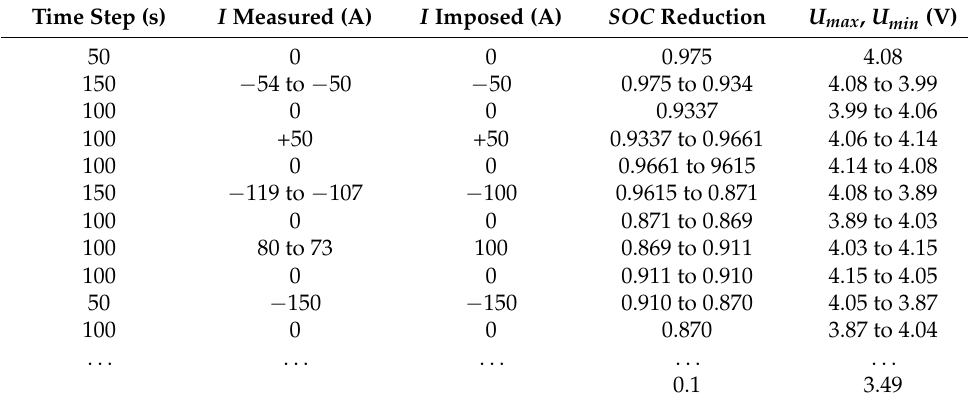
Figure 4. Current profiles used to cycle the battery cell ( a ) (imposed current: red, measured current: blue) and State of Charge evolution ( b ). The charging and discharging periods are separated by rest periods, and globally the profile discharges the cell. Table 1. Detailed specification of a full pulse.